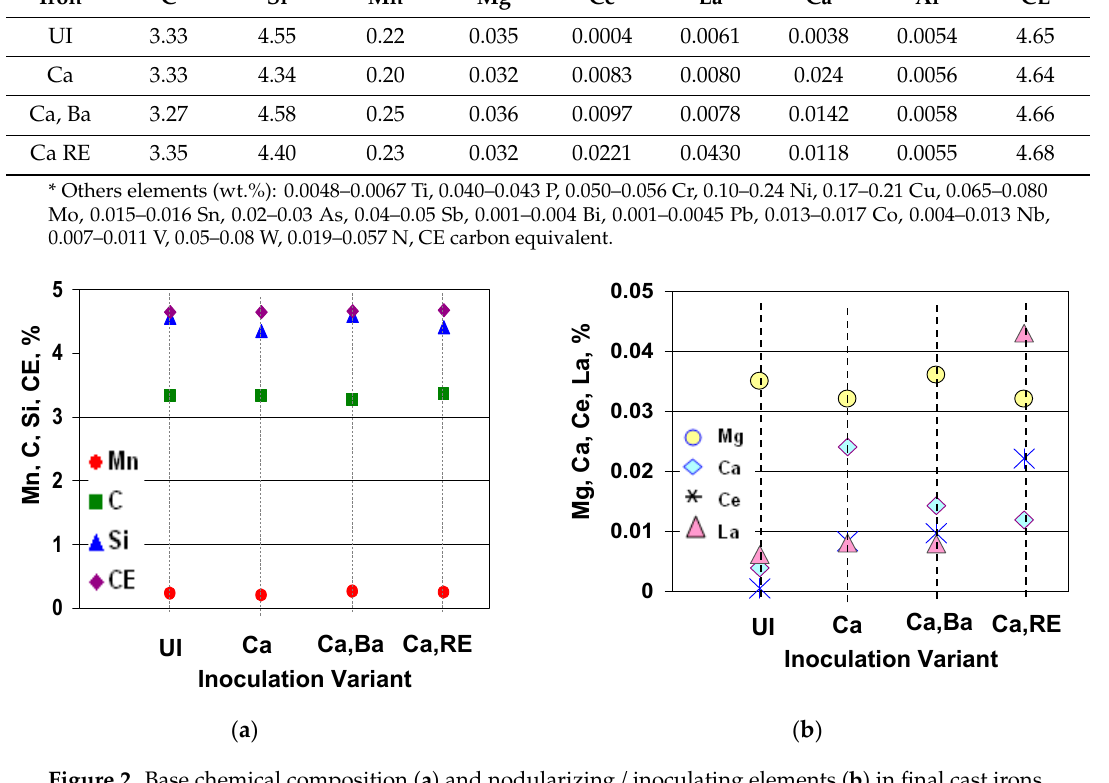
Figure 2. Base chemical composition ( a ) and nodularizing / inoculating elements ( b ) in final cast irons.